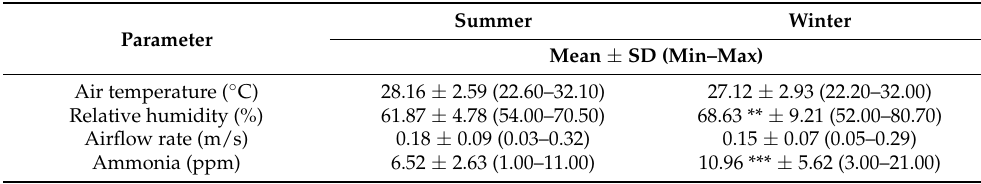
Table 1. Values of house microclimate parameters during five-week broiler fattening in summer and winter.